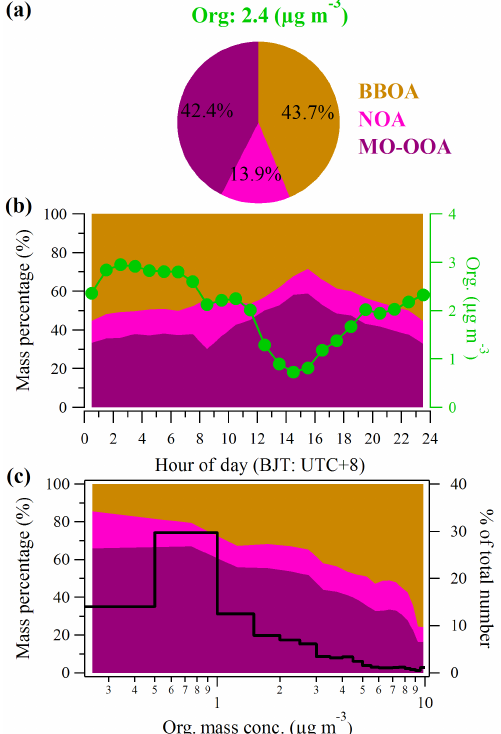
Figure 8. (a) The average mass concentration of OA and mass con- tributions of three OA factors to total OA; (b) the diurnal variations of mass contributions of three OA factors to total OA and the to- tal OA mass concentration; and (c) the average mass contributions of three OA factors as a function of total OA mass concentrations. The black solid line in (c) shows the percentage of the data number in each OA mass bin to the total data